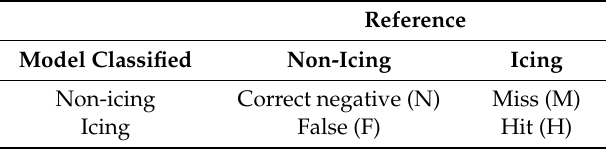
Table 5. A contingency table used in this study to calculate performance metrics.